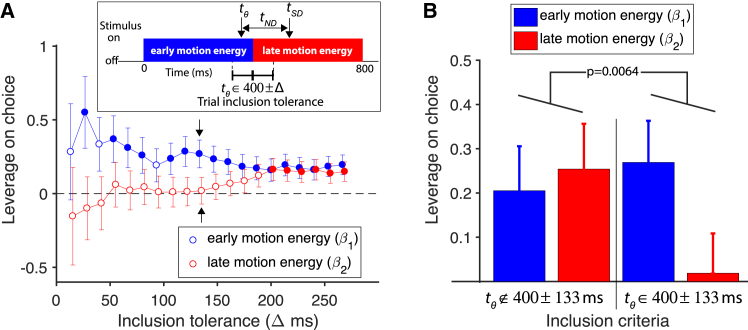
Effect of Trial-to-Trial Variation in the Noisy Motion Information on ChoiceThe analysis compares the leverage of information before and after a putative threshold crossing that terminates integration. Leverage is based on logistic regression of motion energy (right minus left; see STAR Methods), controlling for motion strength.(A) Leverage of early- and late-motion energy (blue and red, respectively). The estimates are shown as a function of the inclusion window. Pairs of points include only trials with estimated termination times (tθ) near 400 ms. (Inset shows how the putative termination time tθ is acquired on each trial. It is the tSD from the clock setting minus the non-decision time estimated from the fits in Figure 2, top row). Filled symbols designate non-zero leverage (p < 0.05). Larger tolerances permit inclusion of more trials but blur the distinction between pre- and post-tθ. Error bars indicate SE.(B) Difference in the leverage of motion energy before and after 400 ms requires tθ to be near 400 ms. The bars on the right side show the leverage values using tolerance of ±133 ms (same value and SE as the points in A marked by arrows). Bars on the left show the average leverages obtained by sampling the complementary trials with tθ outside this tolerance window (5,000 bootstraps of sets of 873 trials; error bars are average of the SE from the bootstraps). The distribution of differences (β1–β2) rarely exceeds the observed difference (p < 0.007). Combined data from subjects 1–4 using motions strengths 0%, ±3.2%, and ±6.4% coherence.